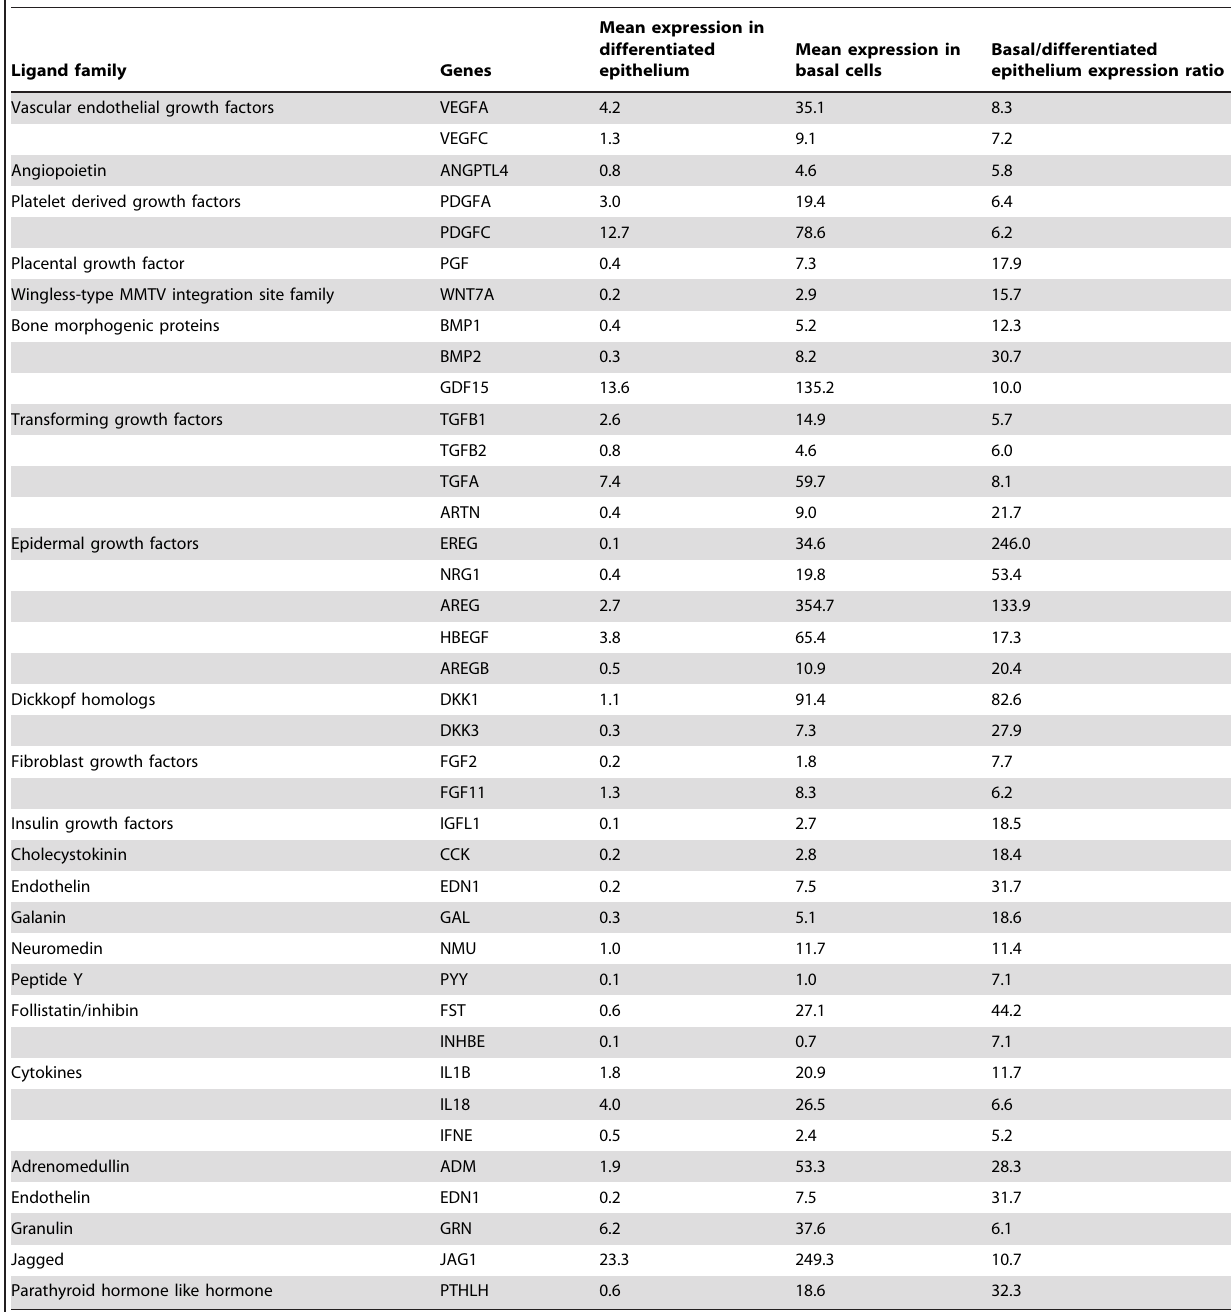
1 Genes identified by GATHER KEGG categories (Table 2, Table S3), Gene Ontology categories (Table 3, Table S5) and/or Canonical Pathways (Table 4, Table S6).